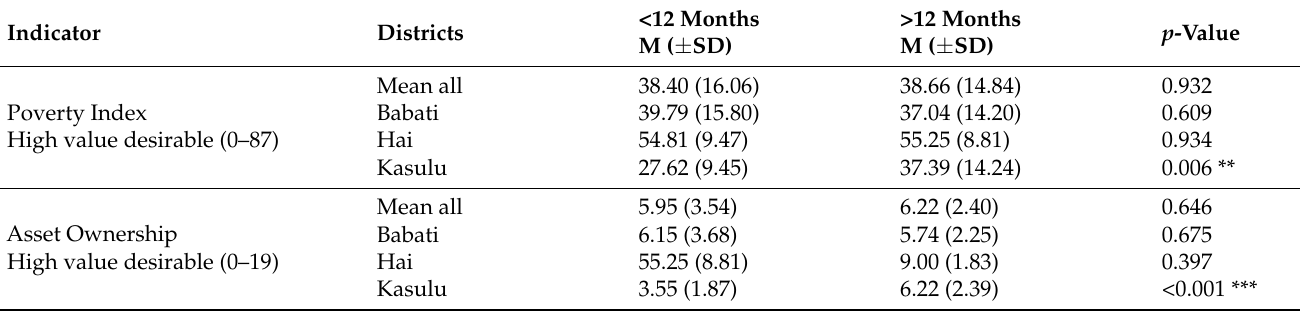
Table 8. Mean differences in poverty indicators between farmers registered for <12 months